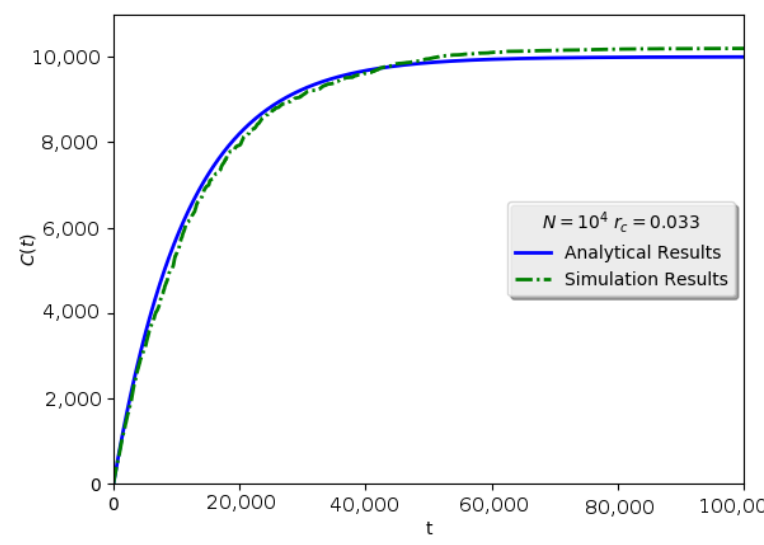
Figure 10. Simulation results for the grid geometric network, N = 10 4 , r c = 0.033, mean number of neighbors = 34. Similarly to the previous simulation results, there is a fit between the modeling and